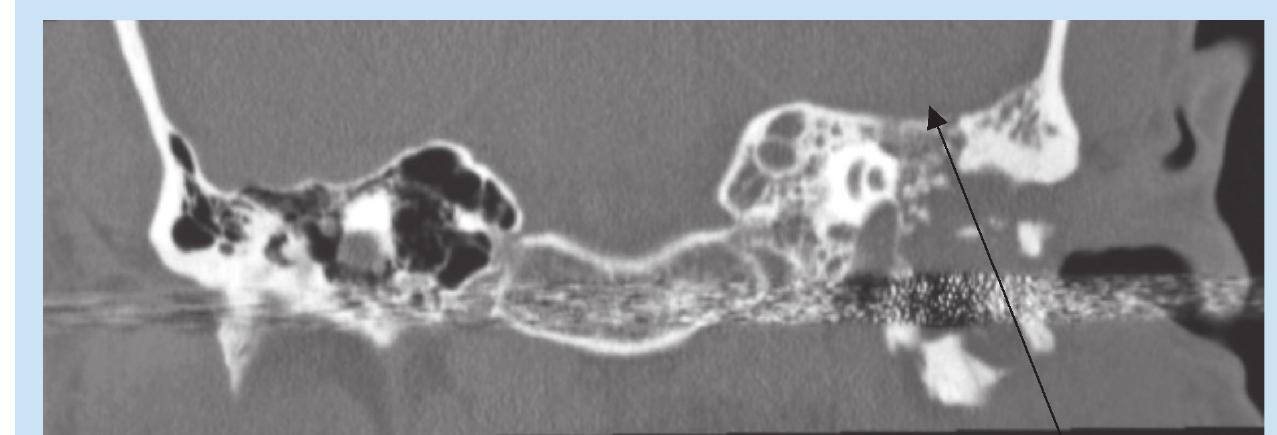
Fig. 6. Coronal CT showing the infiltrating cholesteatoma, extending into the middle ear with tegmen tympani dehiscence (arrow).